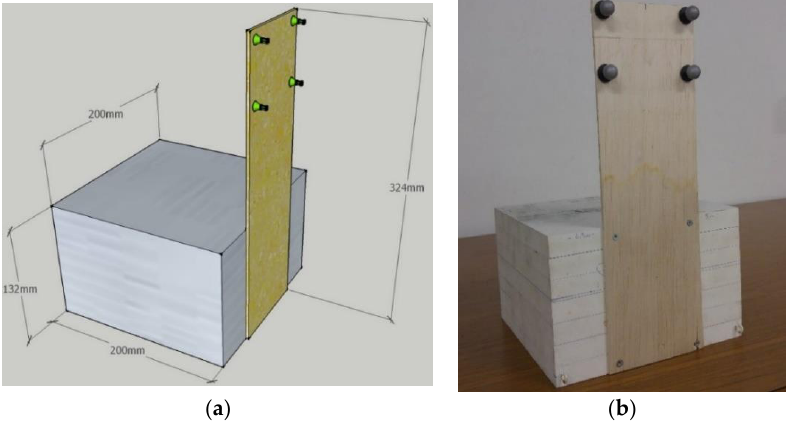
Figure 2. The BOX model: ( a ) sketch and dimensions; ( b ) the BOX model as built with its front plate with four reflective markers.